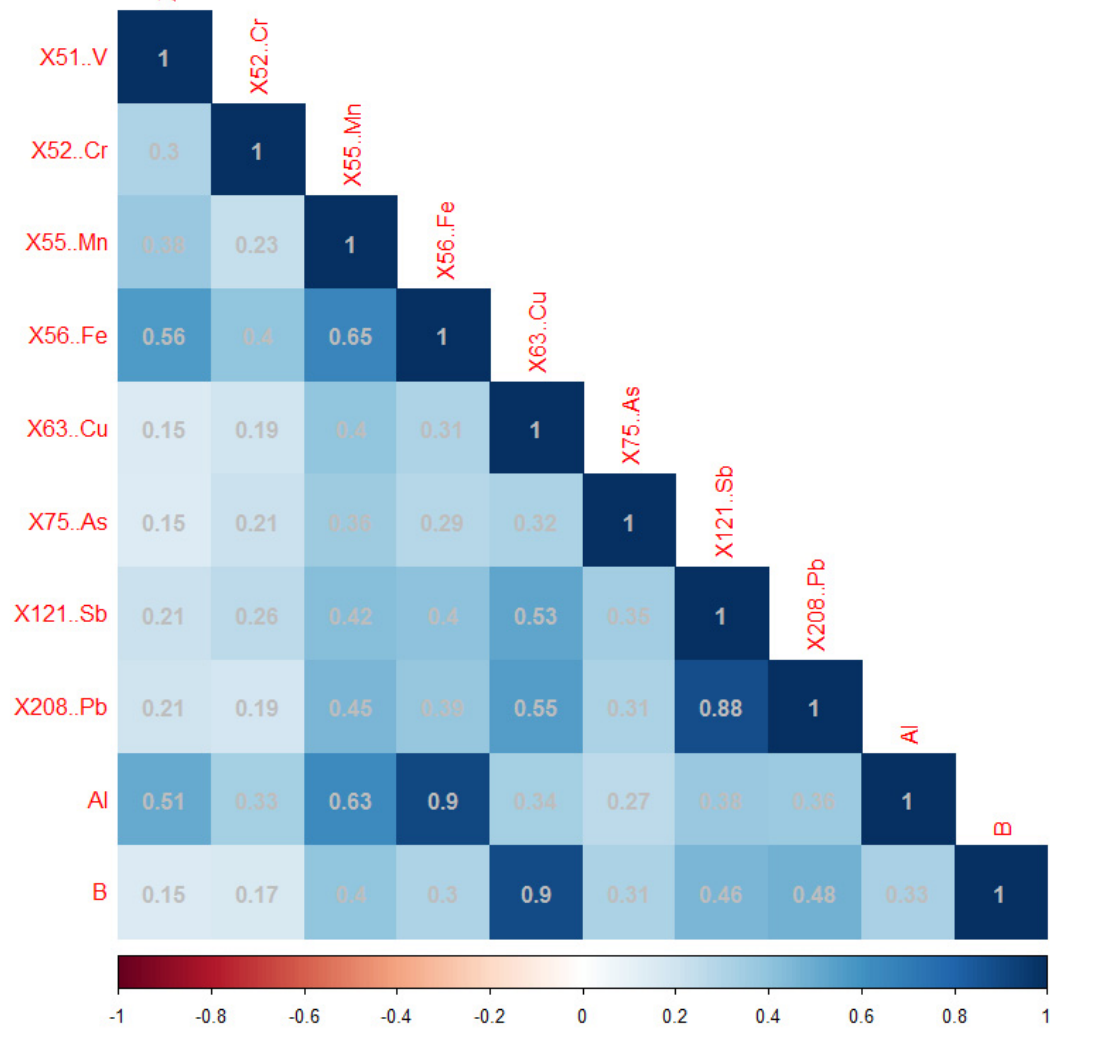
Figure 3. The correlation heatmap of trace element concentrations in the Mn network (on natural log scale).